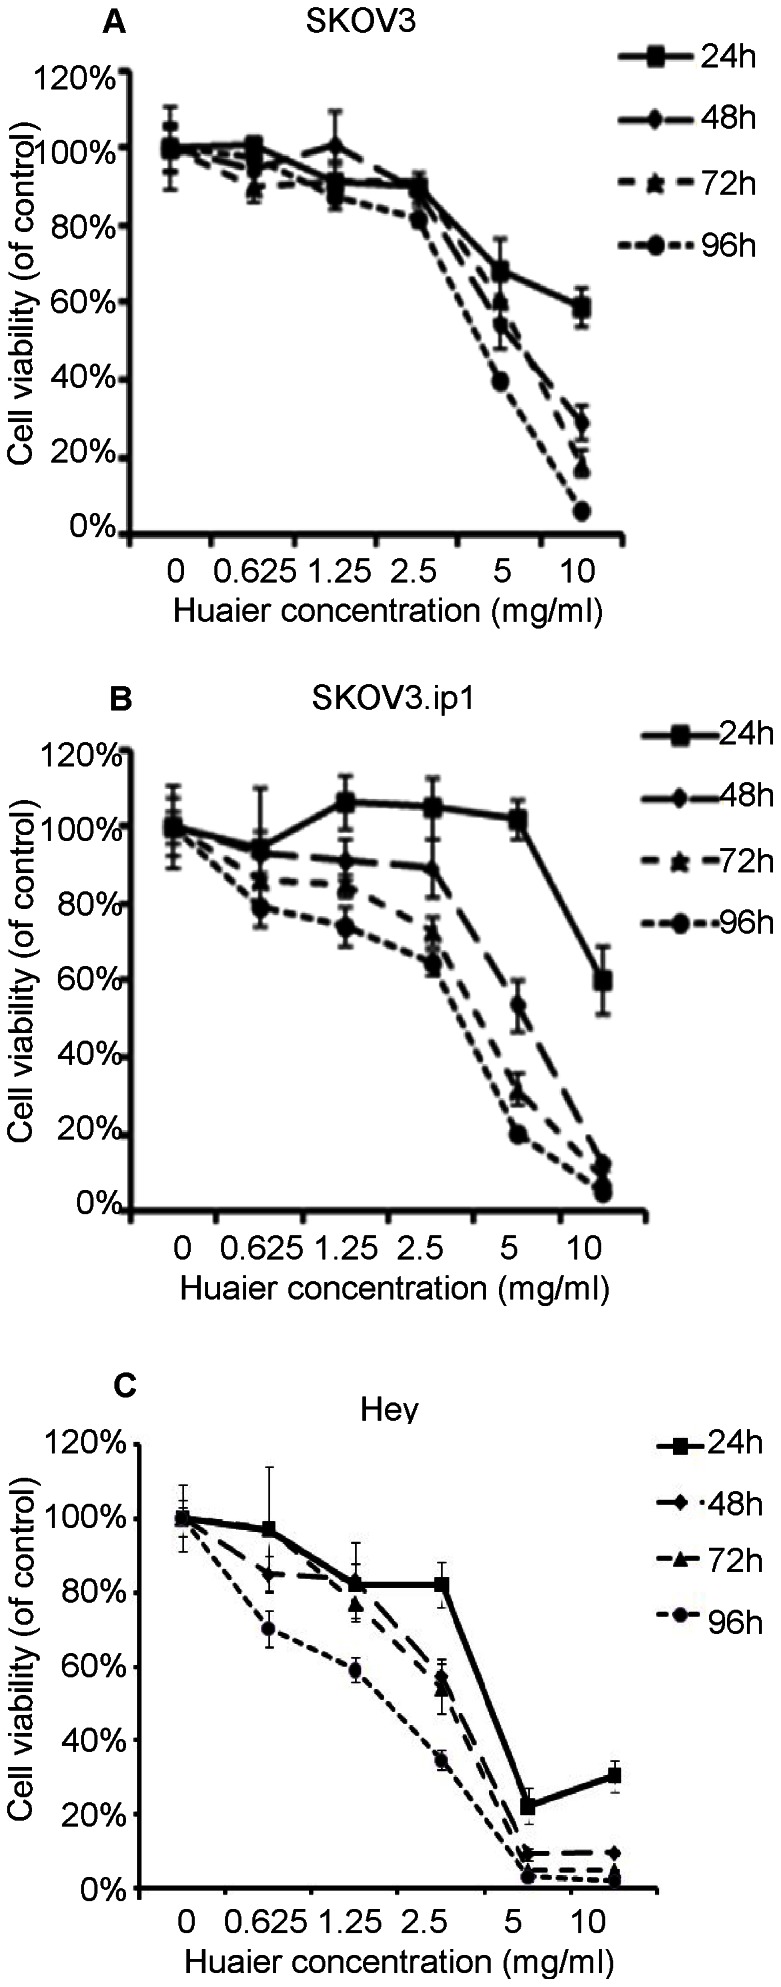
Huaier extract inhibits ovarian cancer cell proliferation in vitro.The growth inhibitory effect of Huaier was measured using the SRB assay. SKOV3 (A)SKOV3.ip1 (B) and Hey (C) cells were treated with Huaier for 24, 48, 72 and 96 h. The experiments were performed in triplicate, and the data are presented as the means±SD of three separate experiments.